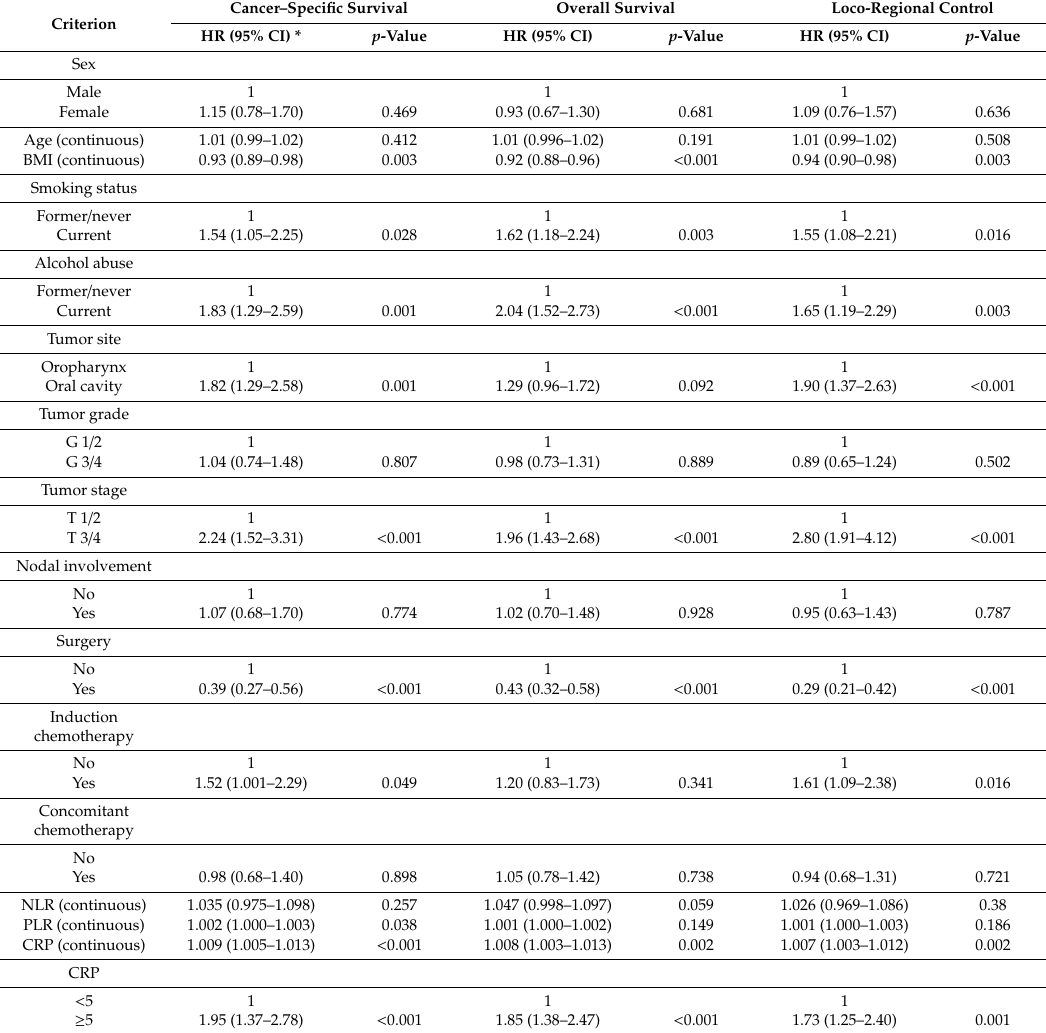
Table 2. Univariate analysis of clinical-pathological parameters for the prediction of cancer-specific survival, overall survival and loco-regional